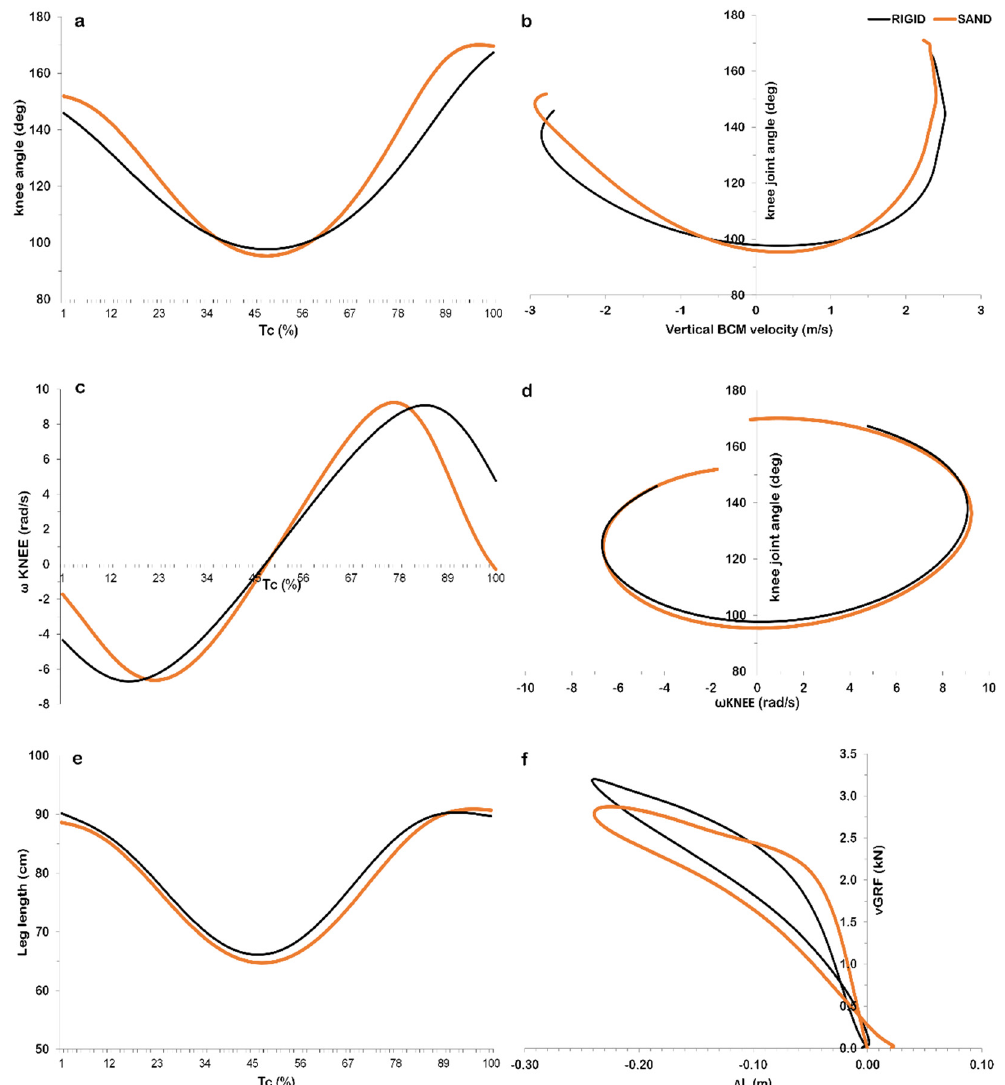
Figure 4. Mean ensemble ( n = 16) time–history curves for the examined drop jump kinetic parameters on rigid (RIGID) and sand (SAND) surface: ( a ) knee joint angle; ( b ) knee joint angle with respect to the body center of mass vertical velocity; ( c ) angular velocity of the knee joint; ( d ) knee joint angle with respect to the angular velocity of the knee joint; ( e ) leg length; ( f ) change of leg length (0 = leg length at the instant of touchdown from the drop phase) with respect to the vertical Ground Reaction Force. Abbreviations: Tc: contact time; BCM: body center of mass; ω KNEE: angular velocity of the knee joint; Δ L: change of leg length; vGRF: vertical Ground Reaction Force. NOTE: curves depicted in Figure 4a,c,e are normalized with respect to Tc.